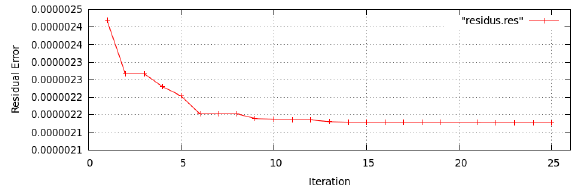
Figure 9: The south portal point cloud colorized. The points re- colorized in red are invisible from the digital image pose Second experiment : we use our pose optimization method to entirely colorize a smaller part of the south portal : the Virgin Mary statue. Our goal is to obtain an accurately colorized point cloud with photo-realistic quality. To obtain this, ideally, the re- sult would be to have each 3D point visible from the camera